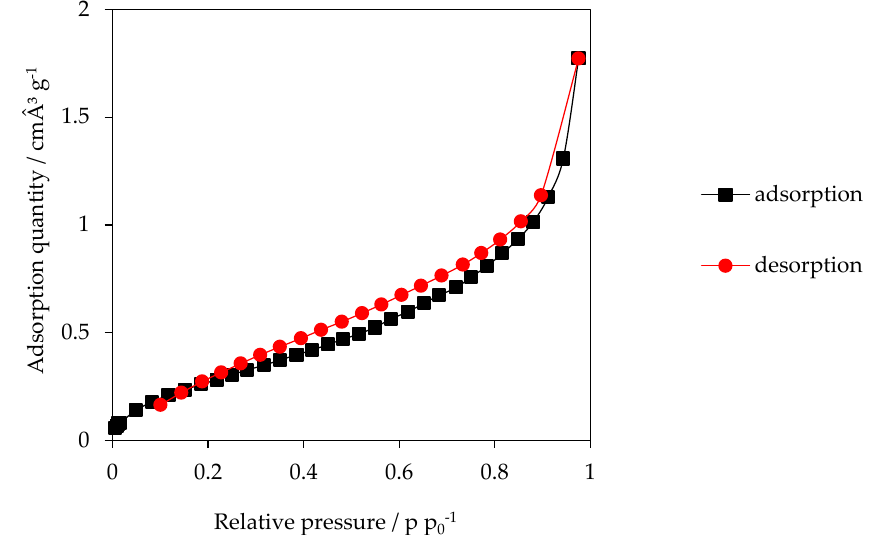
Figure 3. Sorption isotherm of sample HTC-200-5. Adsorptive gas: nitrogen.